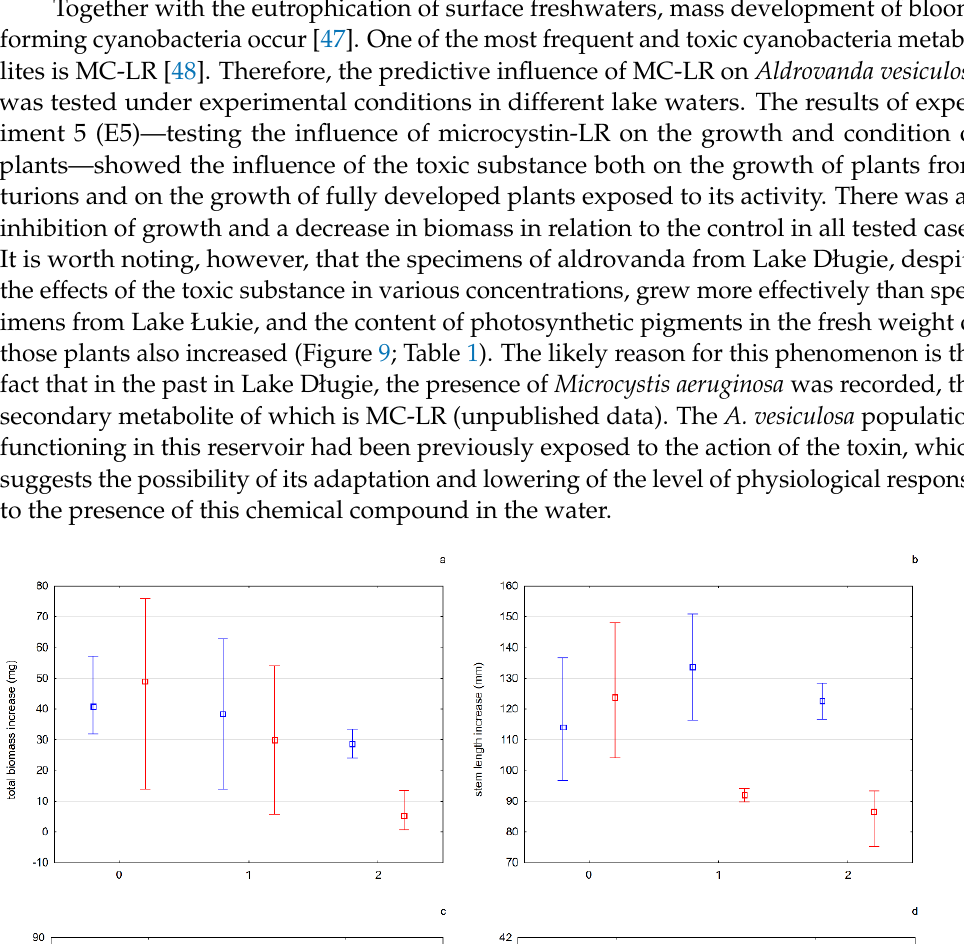
Figure 8. The influence of the available N-NH 4 ions on the tested features of plants, determining the growth efficiency (( a ) — total biomass increase, ( b ) — stem length, ( c ) — cormus density). Whiskers in- dicate the range of values, and squares indicate the mean.